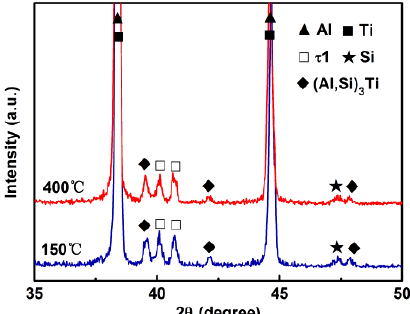
Figure 8. X-ray diffraction (XRD) patterns of the composites thixoformed under mold temperatures of 150 °C and 400 °C.